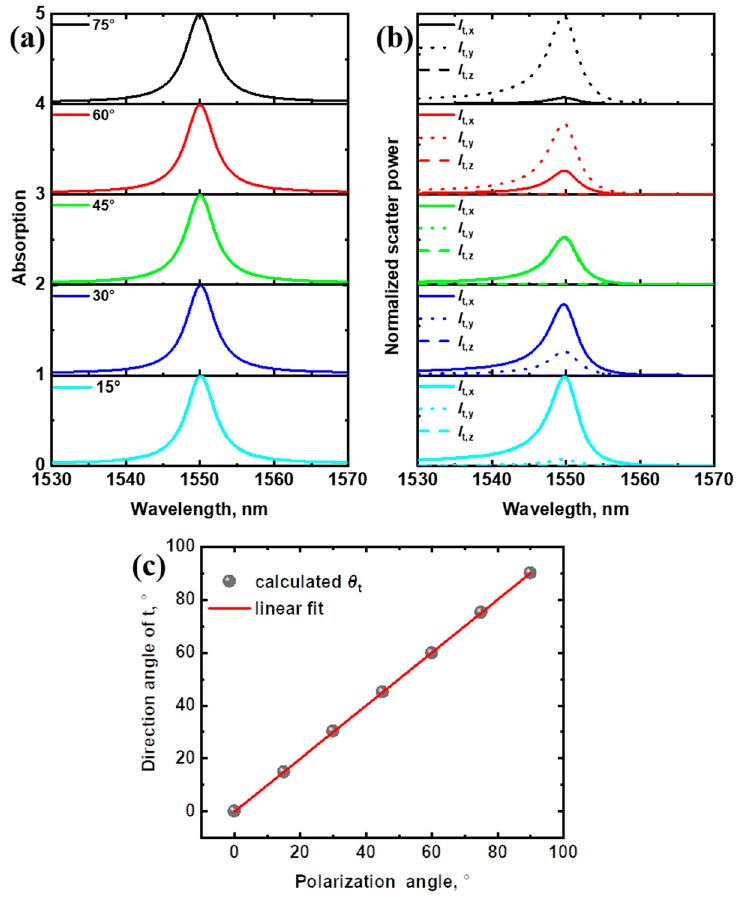
Figure 5. ( a ) Absorption spectra of the MPA for polarization angle from 15 ◦ to 75 ◦ with a step interval of 15 ◦ . ( b ) Normalized scatter power of t . ( c ) Linear fitting of θ t at resonant wavelength as a function of polarization angle.